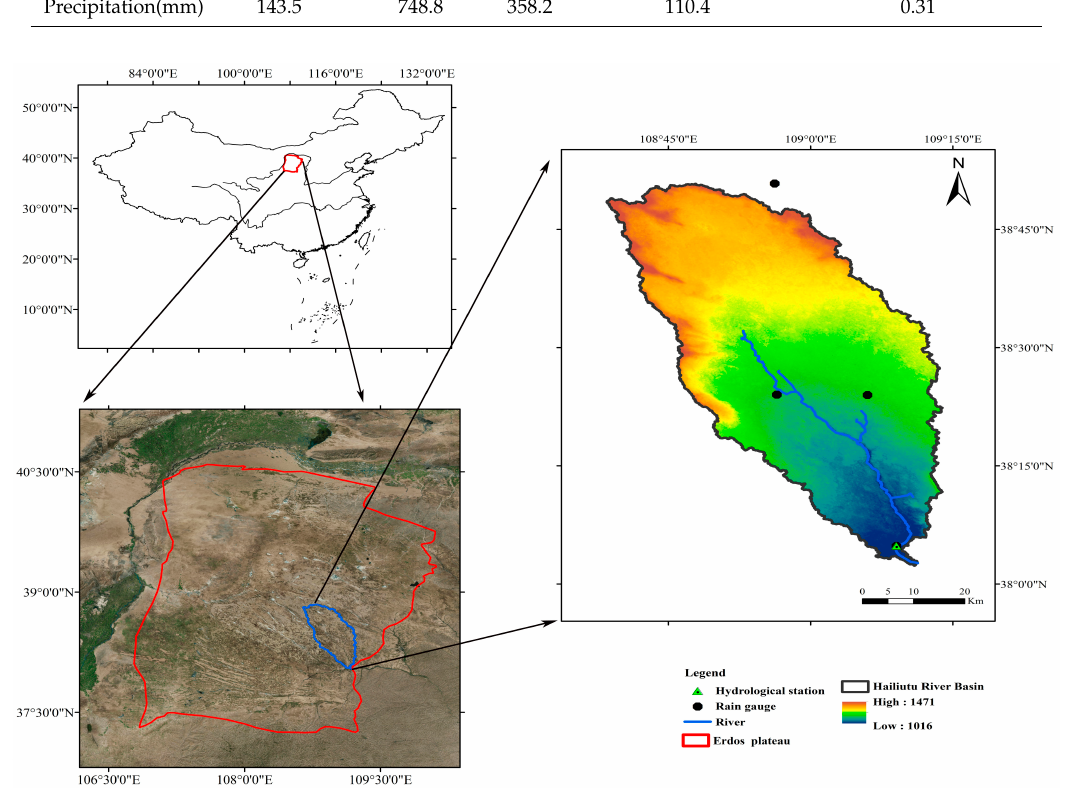
Figure 1. Summary of the study area: location of the catchment, observation stations, and digital elevation model. Table 2. Statistical values of Hailiutu River Basin for annual average streamflow and precipitation.